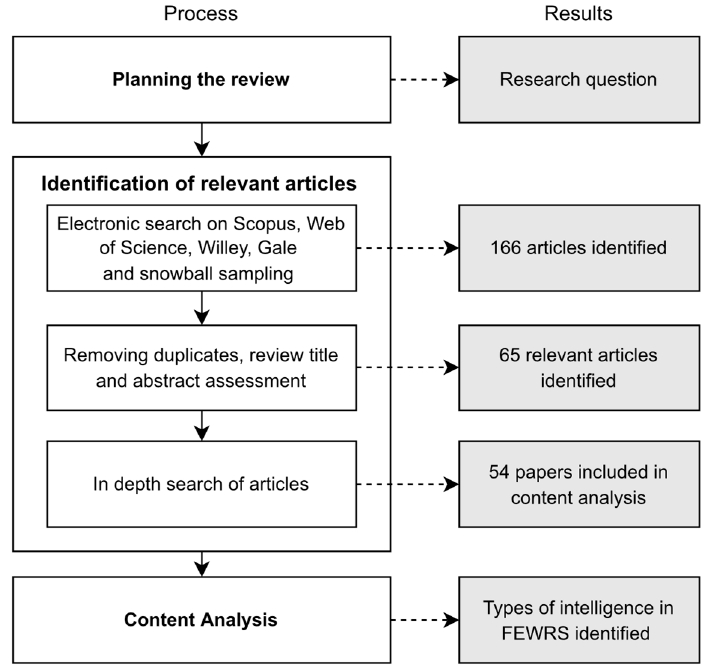
Figure 1. The workflow of the review process.